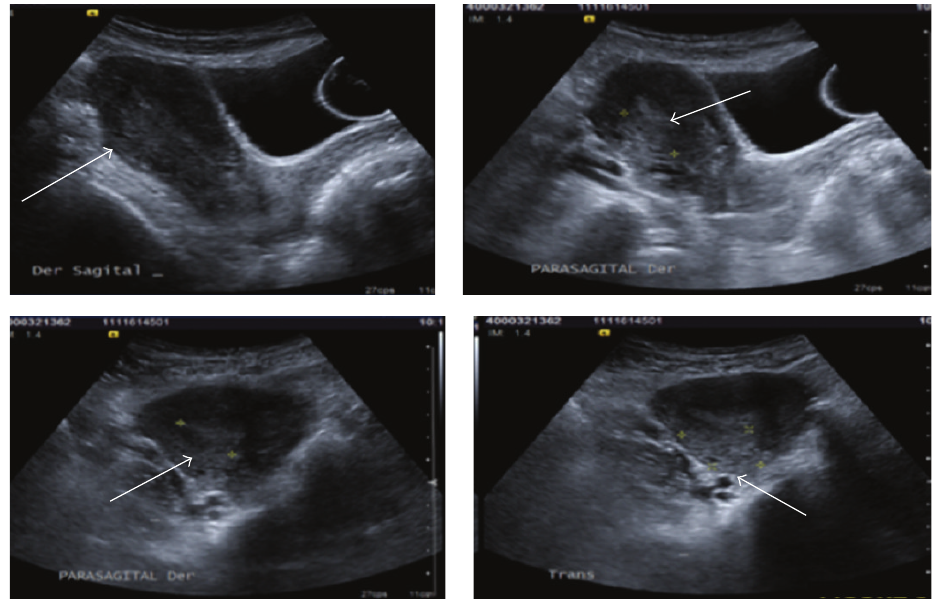
Figure 6: Pelvic US shows uterine myoma in posterior wall of 30 × 25 × 20 mm. Two myomas in the interior